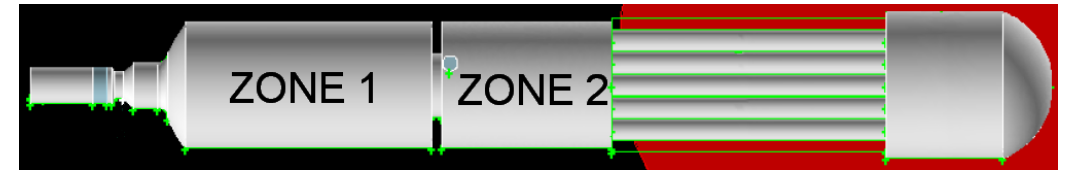
Figure 2. The numerical model for the SRU thermal reactor